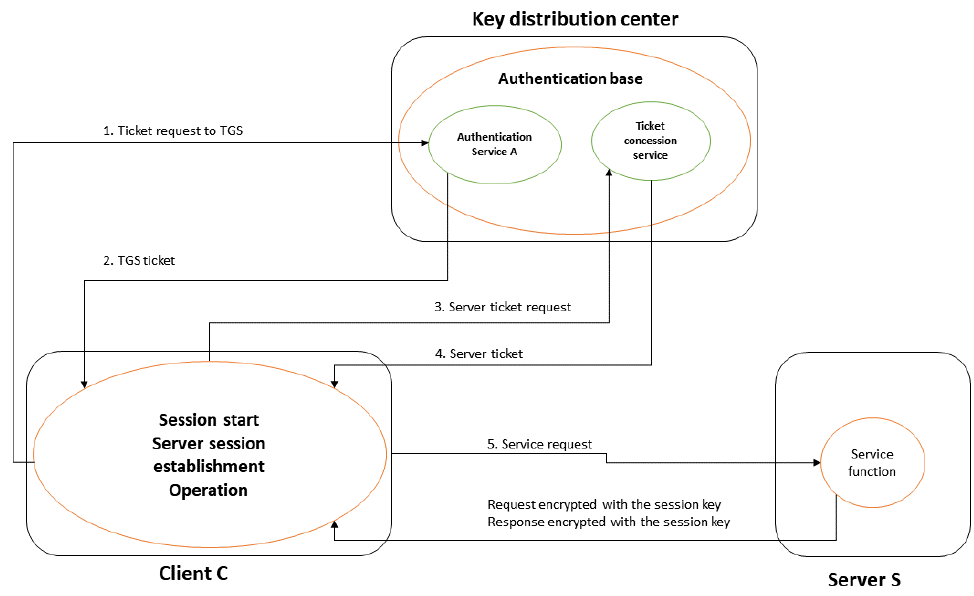
Figure 4. Kerberos architecture, adjusted to the educational data analysis model.